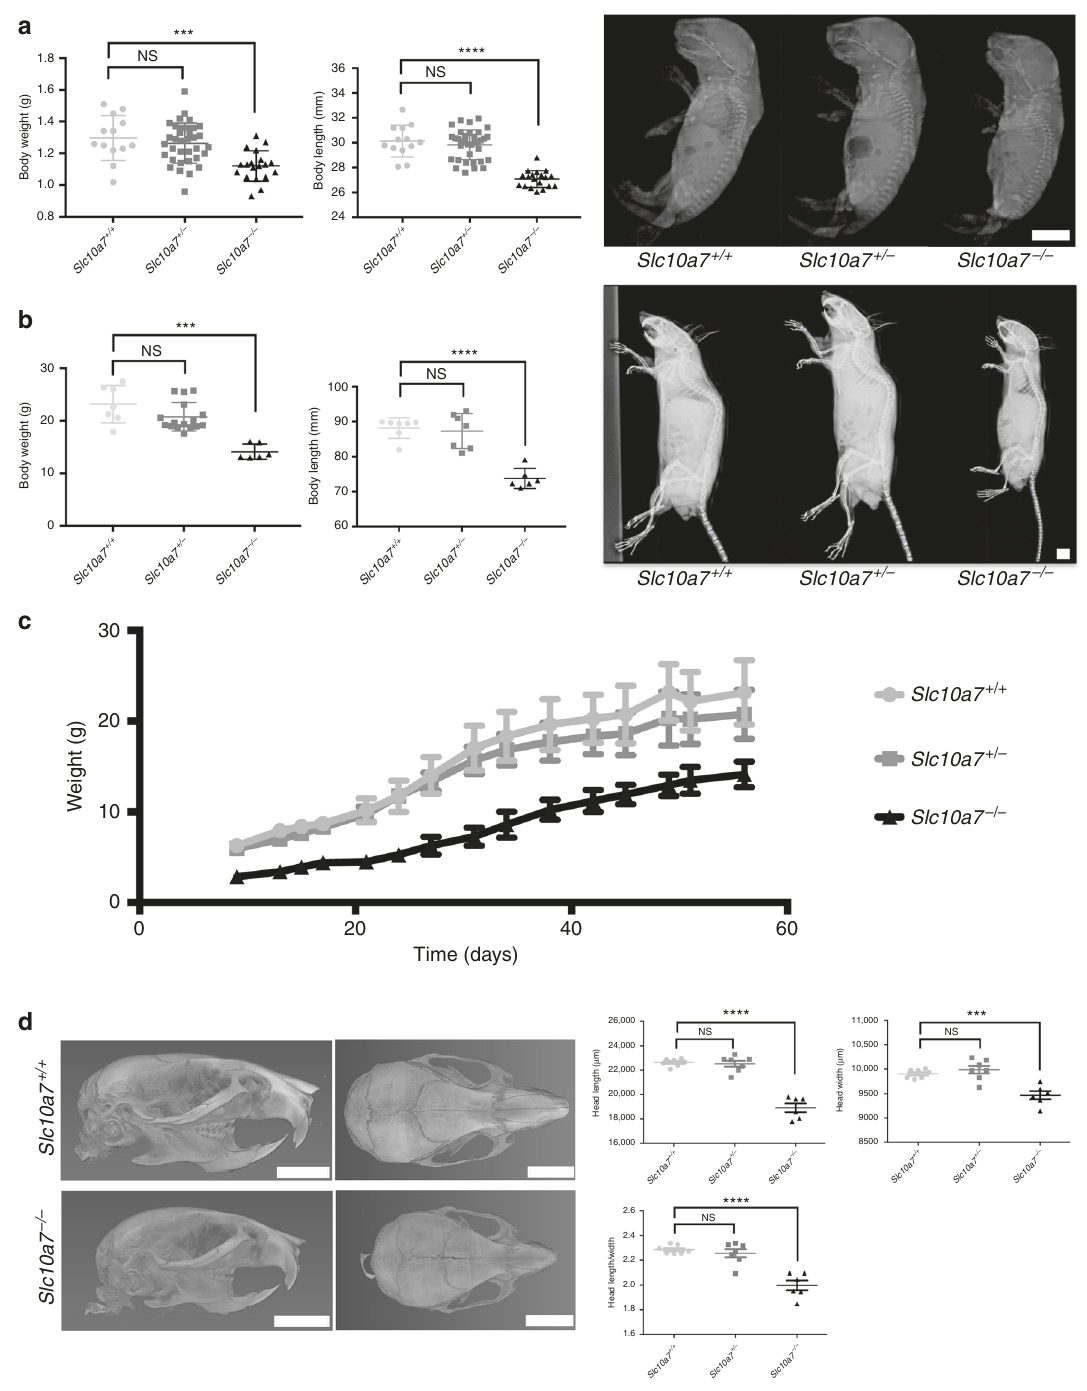
Fig. 3 Slc10a7 − / − mice display skeletal dysplasia with skull anomalies. a , b Measurement of body weight and naso-occipital length (body length) and radiographic assessment of Slc10a7 + / + , Slc10a7 + / − and Slc10a7 − / − mice at birth ( a ) or at 8 weeks ( b ), demonstrating that Slc10a7 − / − mice exhibited a skeletal dysplasia with a more rounded skull. c Evolution of body weight demonstrating the growth delay in Slc10a7 − / − mice compared with wild-type littermates. d Three-dimensional reconstruction of 8-week-old mouse skulls by μ CT analysis and skull length and width measurements, demonstrating that Slc10a7 − / − skulls are less elongated than wild-type skulls. Scale bars = 5 mm. Data are expressed as mean ± SD. NS, nonsigni fi cant; *** p ≤ 0.001; **** p ≤ 0.0001 (two-tailed t- test). n = 13 ( Slc10a7 + / + ), n = 35 ( Slc10a7 + / − ) and n = 19 ( Slc10a7 − / − ) at birth; n = 7 ( Slc10a7 + / + ), n = 7 ( Slc10a7 + / − )